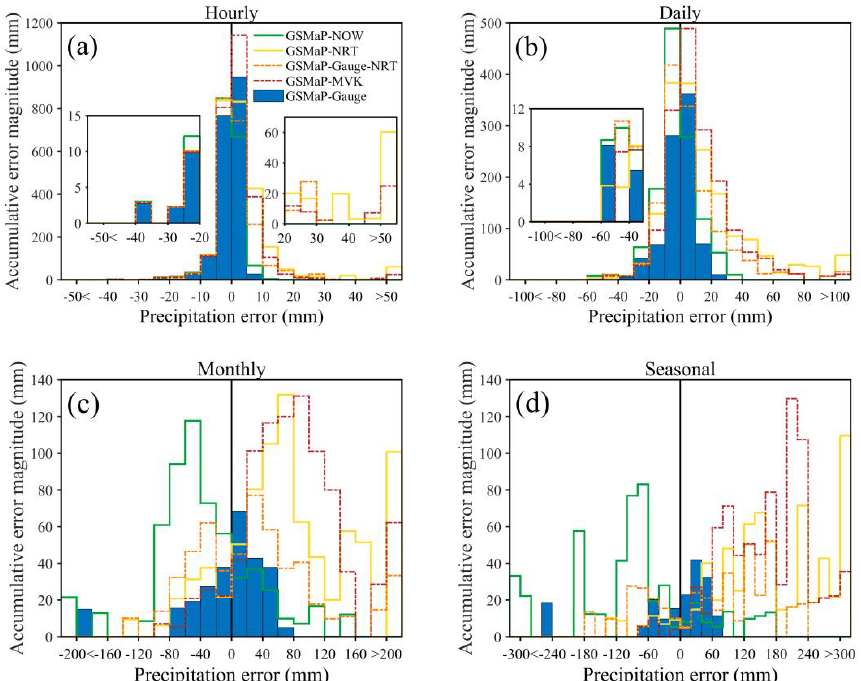
Figure 4. Distribution of precipitation errors from GSMaP SPPs at ( a ) hourly, ( b ) daily, ( c ) monthly, and ( d ) seasonal scales from 29 March 2017 to 31 December 2018. Table 6. SK of precipitation errors from GSMaP SPPs at hourly, daily, monthly, and seasonal scales